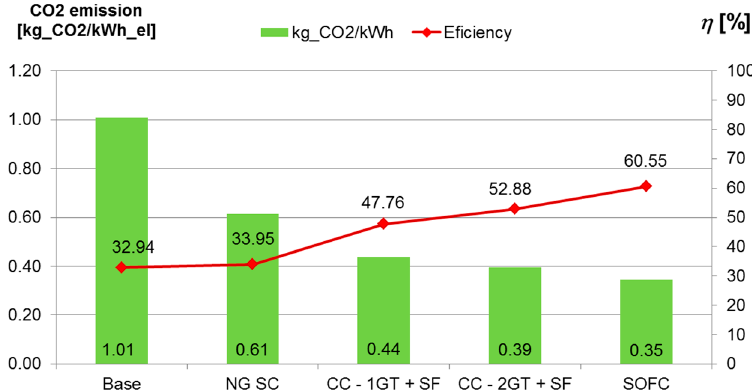
Figure 6. Comparison performance of the repowering plants in terms of plant thermal efficiency and CO 2 emission.